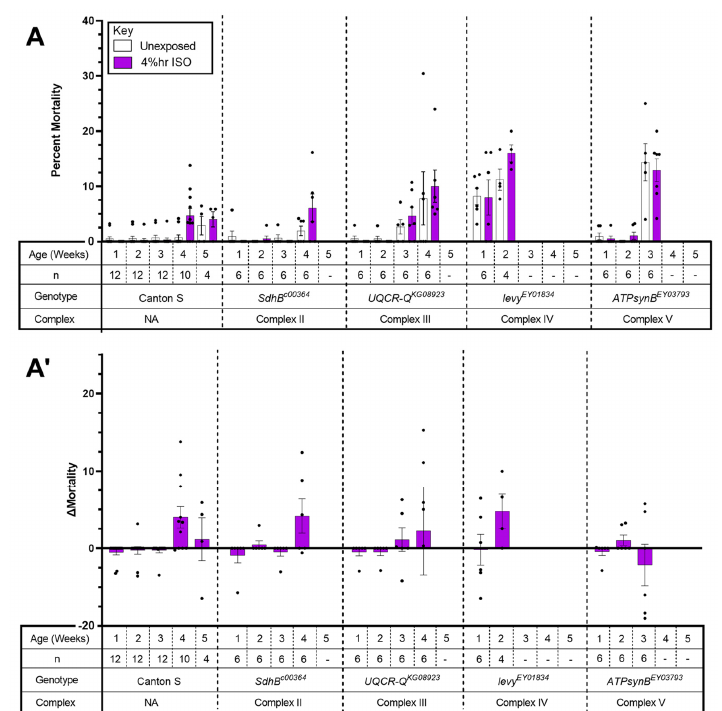
Figure 5. Hyperoxic ISO does not increase 24 h mortality in mutants of Complexes II–V. ( A ). Repeated exposure at weekly intervals for two hours to 2% ISO in 75% O 2 at